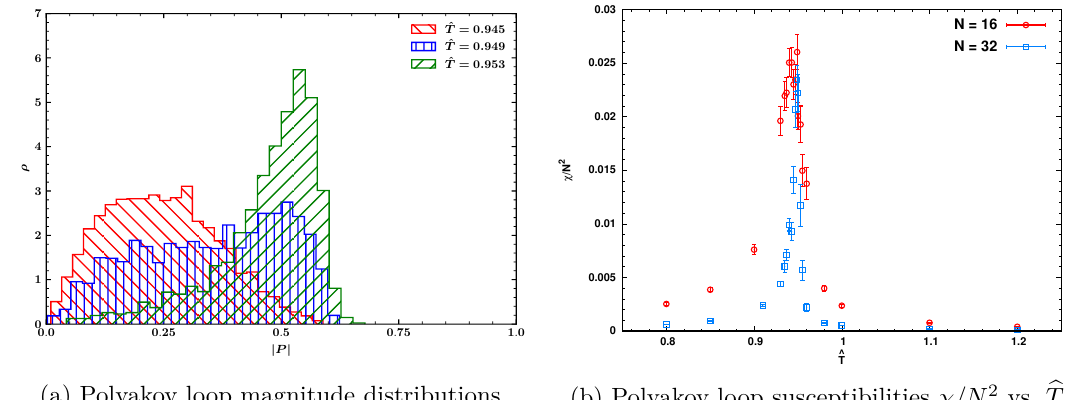
µ = 4 . (a) The distribution of the b 0 . 949 , suggesting a c ≈